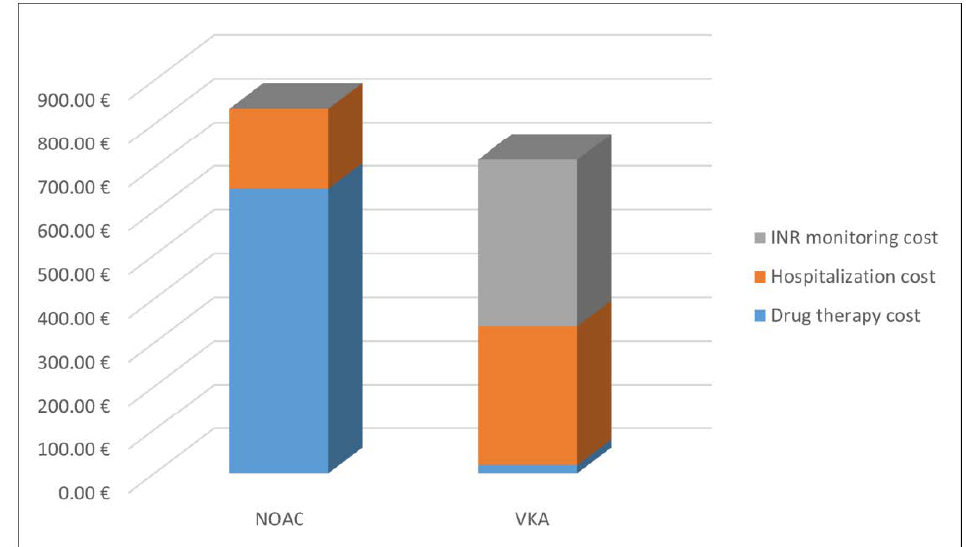
Figure 4. Average cost for patients treated with oral anticoagulants in